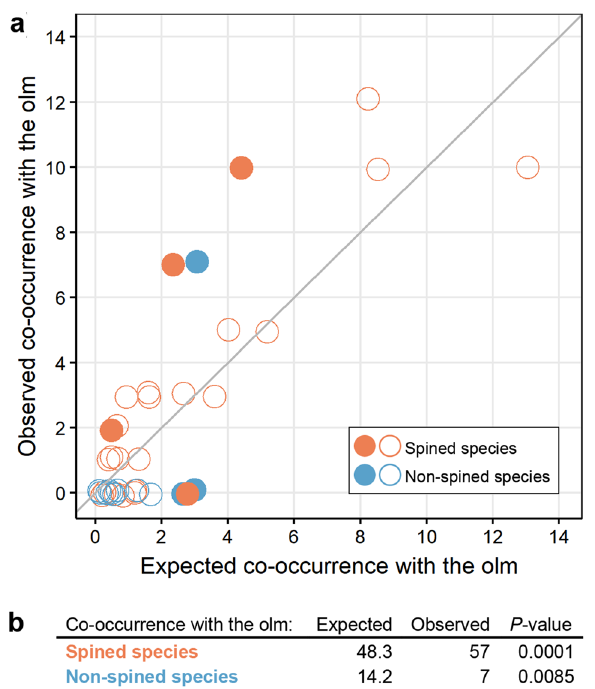
Figure 4. Results of probabilistic models of Dinaric lake Niphargus and olm co-occurrence. ( a ) Expected and observed co-occurrences of all lake Niphargus species. Full circles represent species with significantly positive (above reference line) or negative (below reference line) co-occurrence patterns with the olm. Empty circles represent species with random co-occurrence patterns with the olm. ( b ) Expected and observed co-occurrence patterns of two morphological groups (spined and non-spined lake). Spined lake species co-occur with the olm more frequently than expected whereas non-spined less frequently than expected.